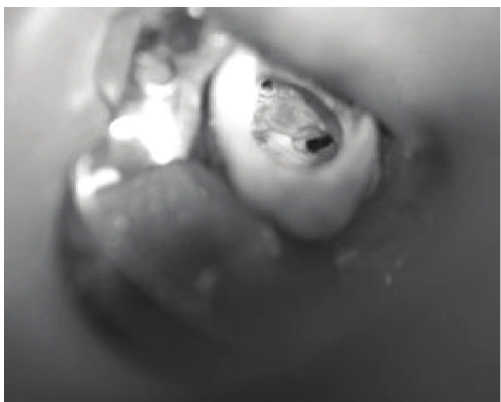
Figure 1: Preoperative radiograph.